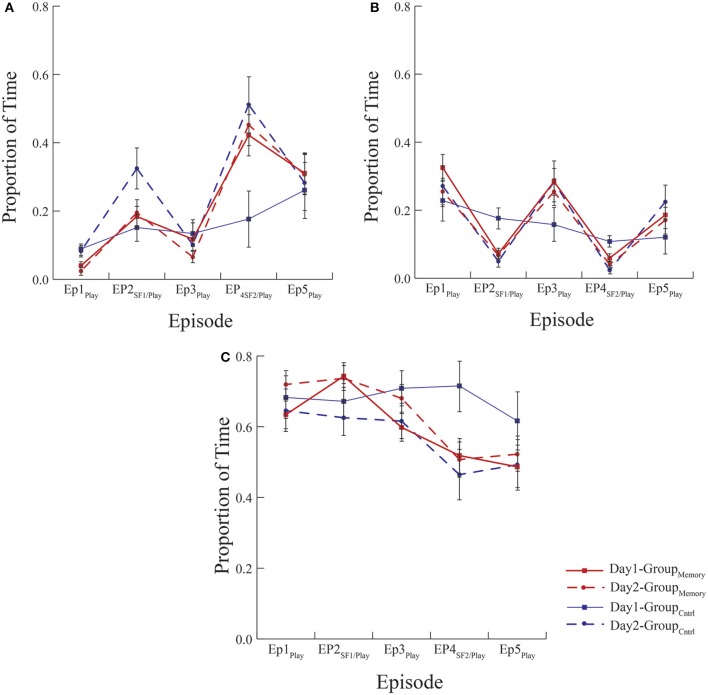
Mean proportion of time infants spent expressing (A) negative, (B) positive, and (C) neutral affect. All groups exposed to the FFSF paradigm showed the standard SF effect regardless of the number of exposures. There were no differences in behavior indicative of memory between GroupMemory infants' first and second exposure to the paradigm or GroupMemory infants' second exposure and GroupControl infants first exposure to the paradigm (see Day 2 comparisons between groups).